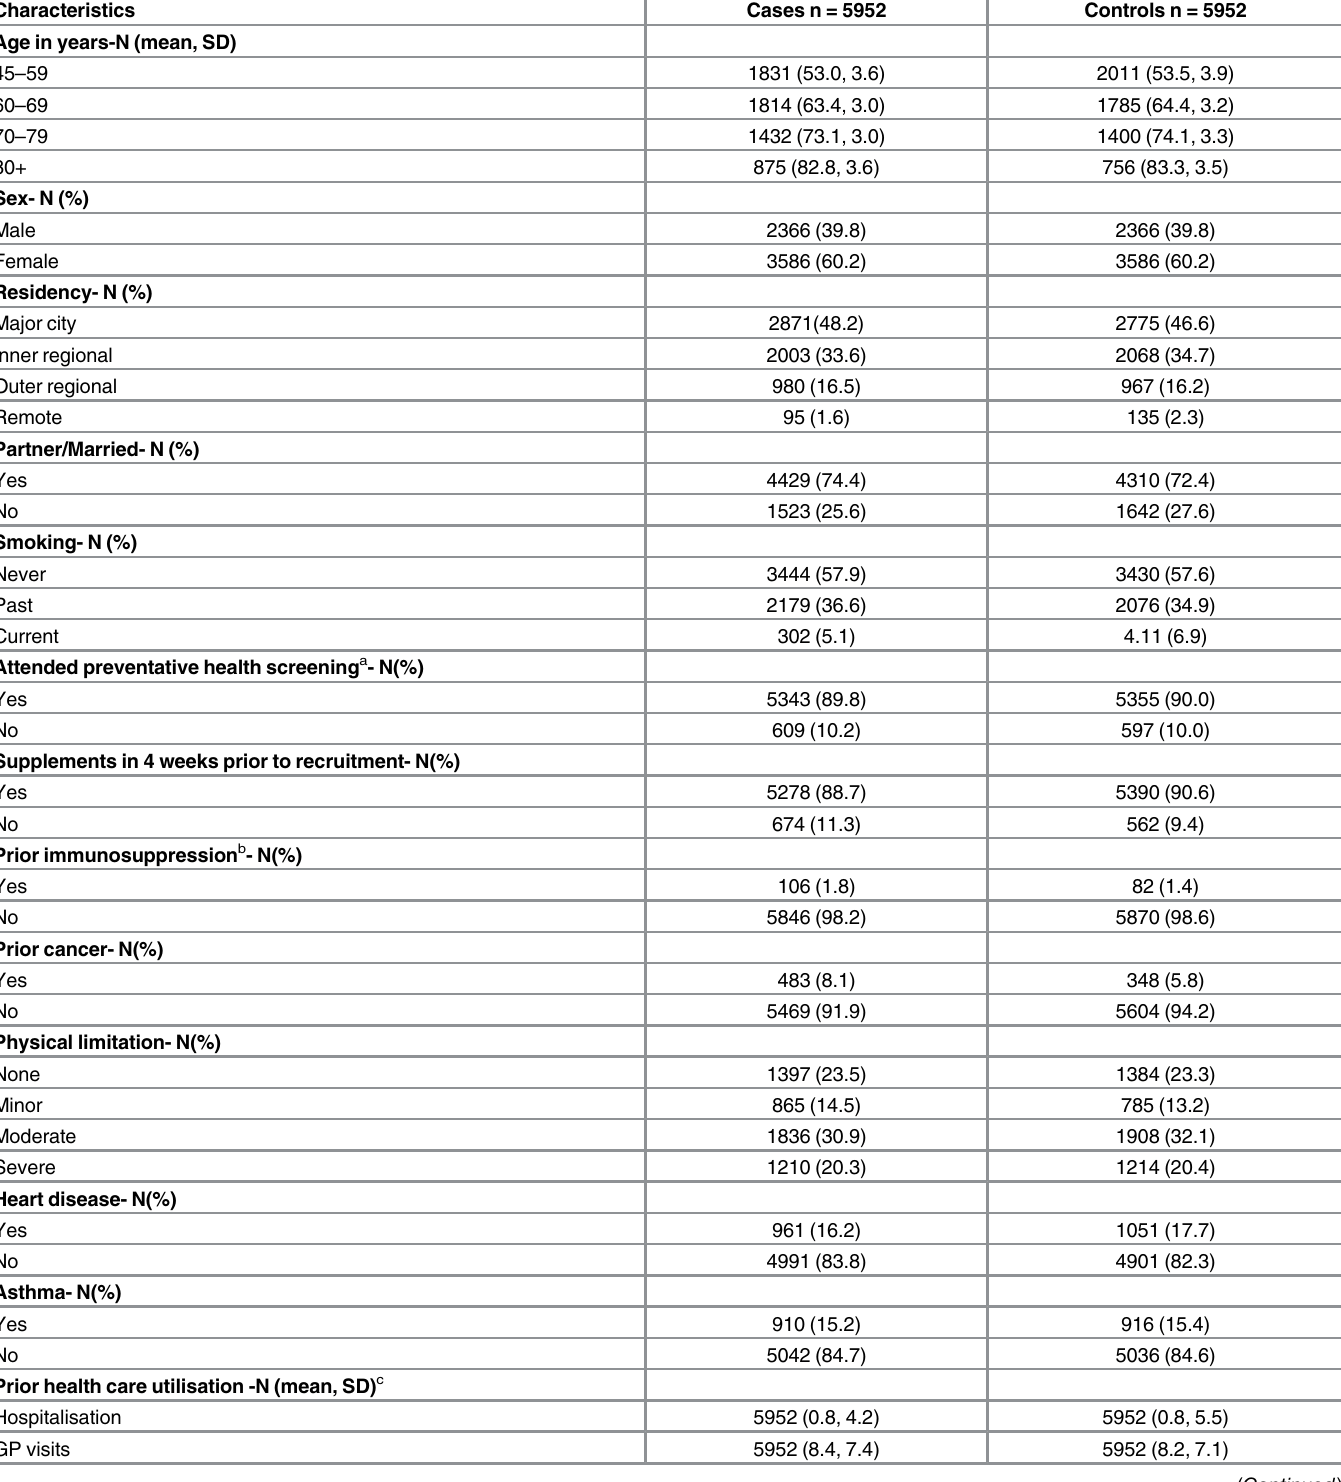
Table 1. Characteristics of cases with herpes zoster and matched